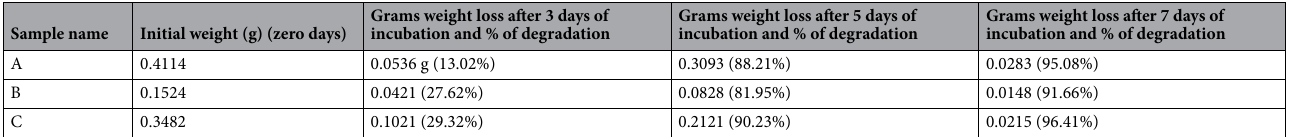
Table 3. Indicated the biodegradability of all three samples.